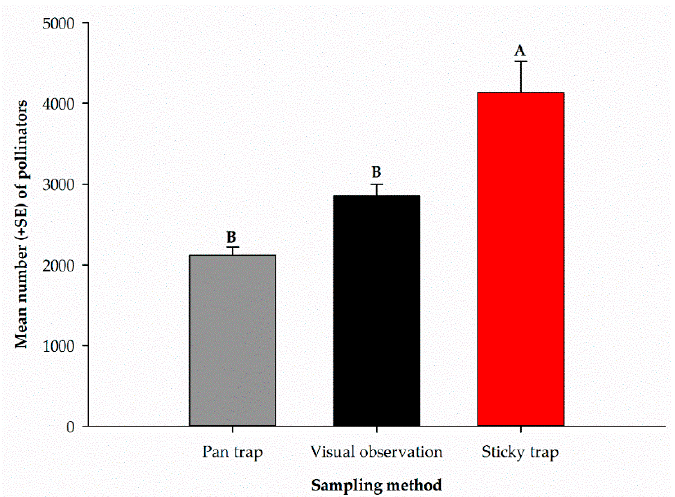
Figure 5. Mean number of all pollinators captured using different sampling methods over the entire sampling period. Mean numbers followed by the same letters are not significantly different ( p > 0.05).